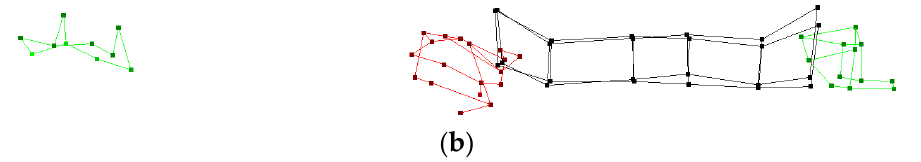
Figure 8. Identified ODS at frequency 100.06 Hz: ( a ) first extreme position; ( b ) second extreme position.